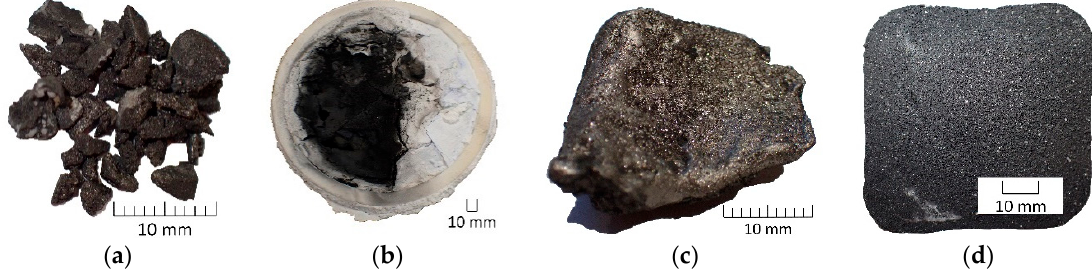
Figure 9. Products of the experiment LCO-C in Design 1: ( a ) slag; ( b ) ceramic ring and mortar seen from the bottom; ( c ) metal; ( d ) powder.